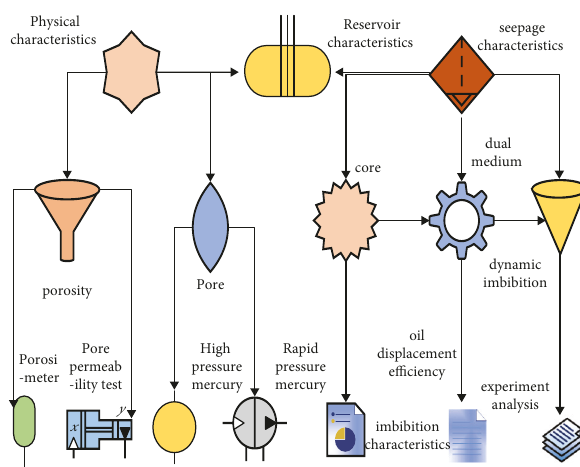
Figure 2: Research route of tight oil reservoir characteristics.